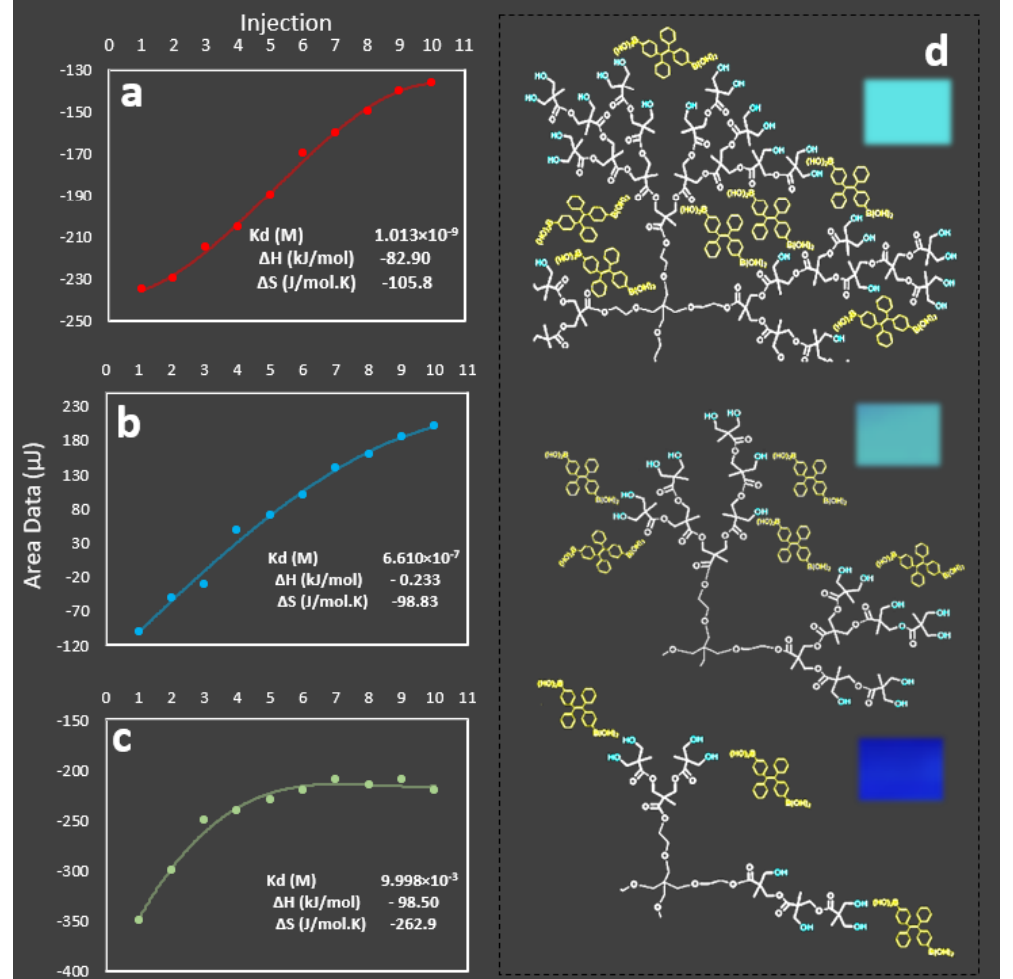
Figure 4. Isothermal titration calorimetry results for nanoprobes including ( a ) generation 4, ( b ) generation 3, and ( c ) generation 2, with estimated equilibrium dissociation constants using fitted model curves. ( d ) Schematic drawings for the interaction of AIE with different HB generations (only a part of each HB molecule was shown). Insets: camera images of nanoprobe solutions captured under a UV light with the excitation wavelength of 365 nm.